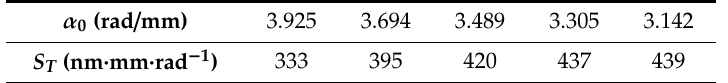
Table 1. Torsion sensitivities ( S T ) of the LFTPCFs with different twist periods.